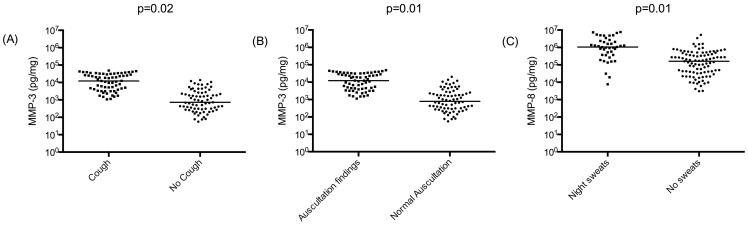
Clinical characteristics and their correlation with MMP-3 and -8 concentrations.MMP-3 concentrations are increased among TB patients who presented with (A) cough and (B) positive findings on auscultation. (C) MMP-8 concentrations are increased among TB patients who reported night sweats.